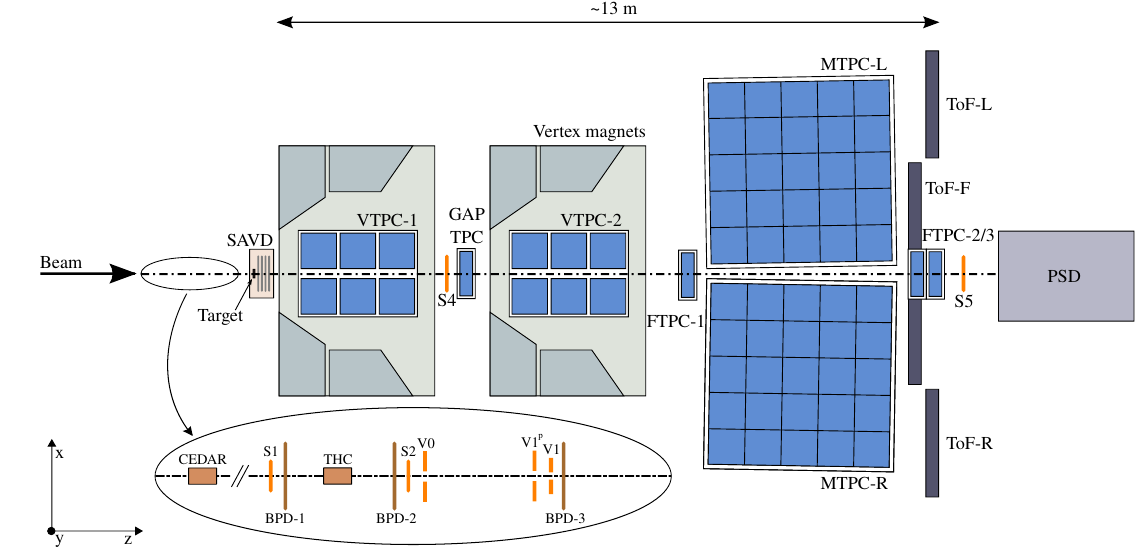
Figure 1. The setup of the NA61/SHINE detector